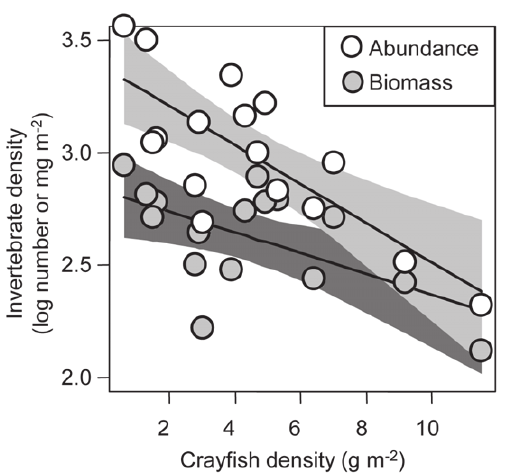
Figure 1. Results from the experimental manipulation of crayfish densities. Each point represents a study pool. Total non- crayfish benthic invertebrate abundance corresponds to open white symbols and gray confidence interval while total non-crayfish biomass corresponds to the gray symbols and darker gray confidence intervals. Benthic invertebrates were negatively associated with crayfish for both non-crayfish benthic invertebrate numerical density (log (invertebra- tes m 2 2 )= 2 0.087 * crayfish + 3.38, R 2 =0.59, P , 0.001) and biomass density (log (invertebrates m 2 2 )= 2 0.046 * crayfish + 2.82; R 2 =0.33, P =0.02). The solid lines denote these best fit linear model and the polygons indicate 95% confidence intervals. Note data are log-